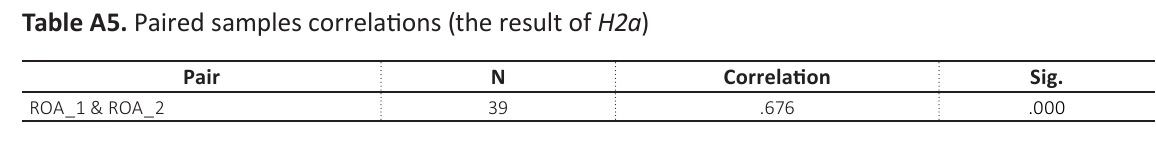
Table A6. Paired samples test (the result of H2a )